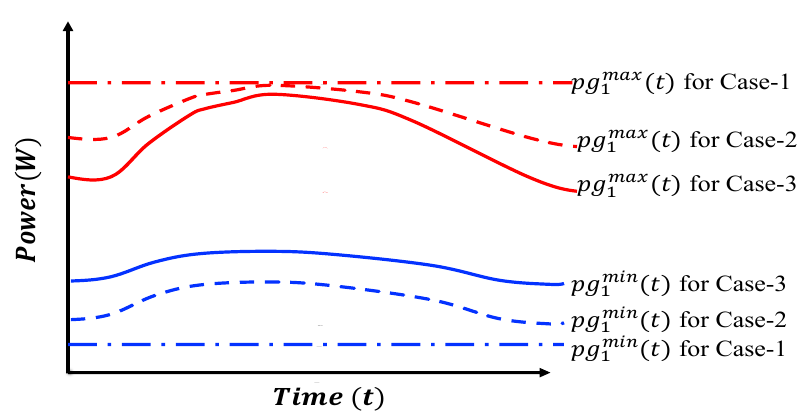
Figure 18. Maximum and minimum power bounds for three cases.